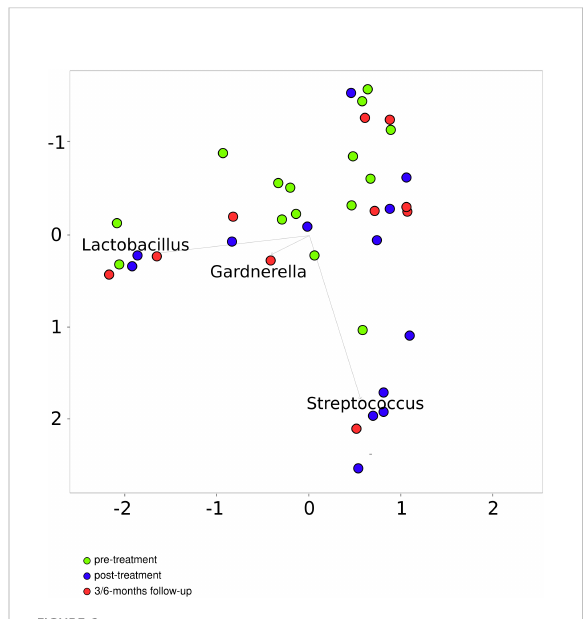
FIGURE 6 Principal coordinates analysis based on the Bray – Curtis index for patients before and after